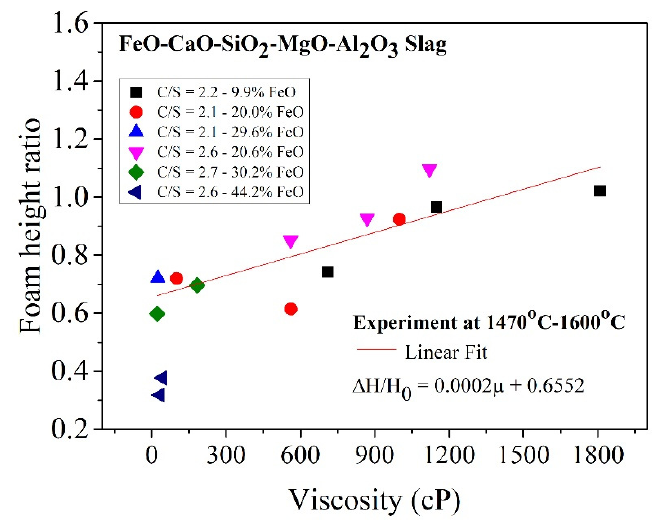
Figure 10. Relationship between viscosity and foam height ratio.